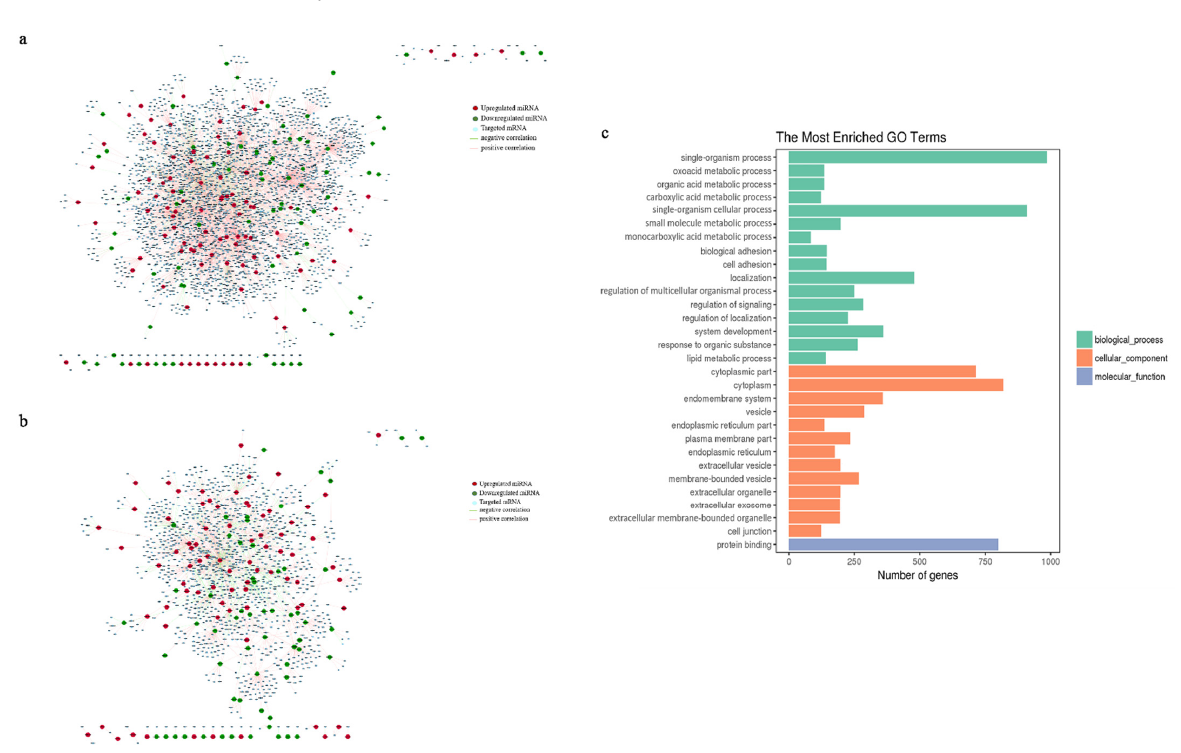
Figure 5. Construction of the co-expression networks for miRNAs–mRNAs and functional analysis of targeted genes. Construction of co-expression networks for ( a ) DEmiRNAs–mRNAs and ( b ) DEmiRNAs–DEmRNAs. Data with |Pearson’s correlation coefficient| ≥ 0.7 and p < 0.05 are shown in the networks. Red, green, and blue dots represent significantly upregulated miRNAs, signifi- cantly downregulated miRNAs, and targeted mRNAs, respectively. The pink and green lines rep- resent positive and negative correlations, respectively. ( c ) Top 30 GO terms in the GO enrichment analysis of targeted DEmRNAs. Green, orange, and purple represent BP, CC, and MF, respectively. MicroRNA, miRNA; differentially expressed, DE; biological process, BP; cellular component, CC; molecular function, MF. Table 3. The number of mRNAs targeted by miRNAs.